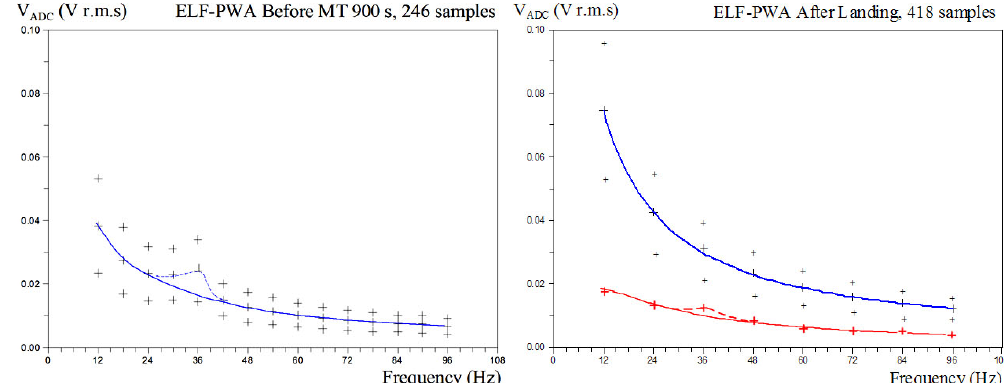
Fig. 3. Frequency distribution of two ELF data sequences with the SNR of bin 36 respectively larger (left panel), and smaller than 1 (right panel). Crosses are mean values and standard deviations. Solid blue lines are LFR fits, excluding bin 36 (see text). Solid red line is the LFR fit of smallest values of the surface sequence excluding bin 36. Dashed lines emphasize the gap between measurements and LFR